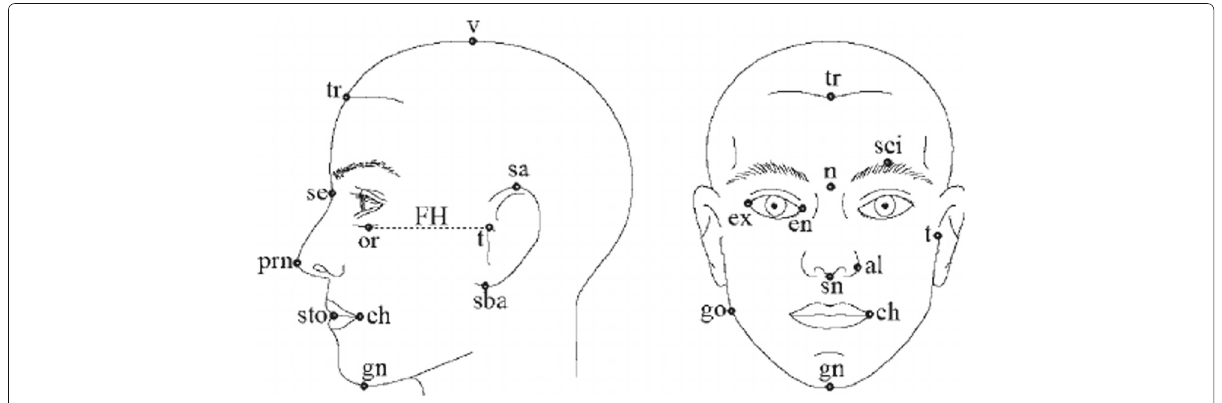
Fig. 1 Anthropometric points on the face [56]